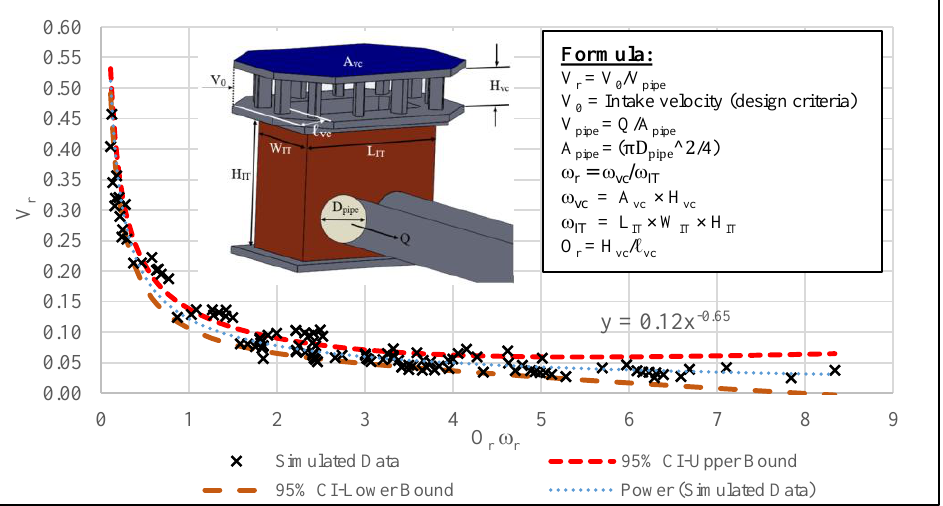
Figure 13. Relationship between V r against ω r .